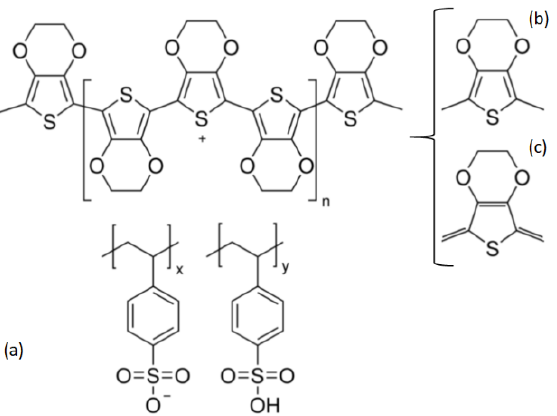
Figure 1. Structure of ( a ) PEDOT:PSS. ( b ) Benzoid and ( c ) quinoid structures of PEDOT.